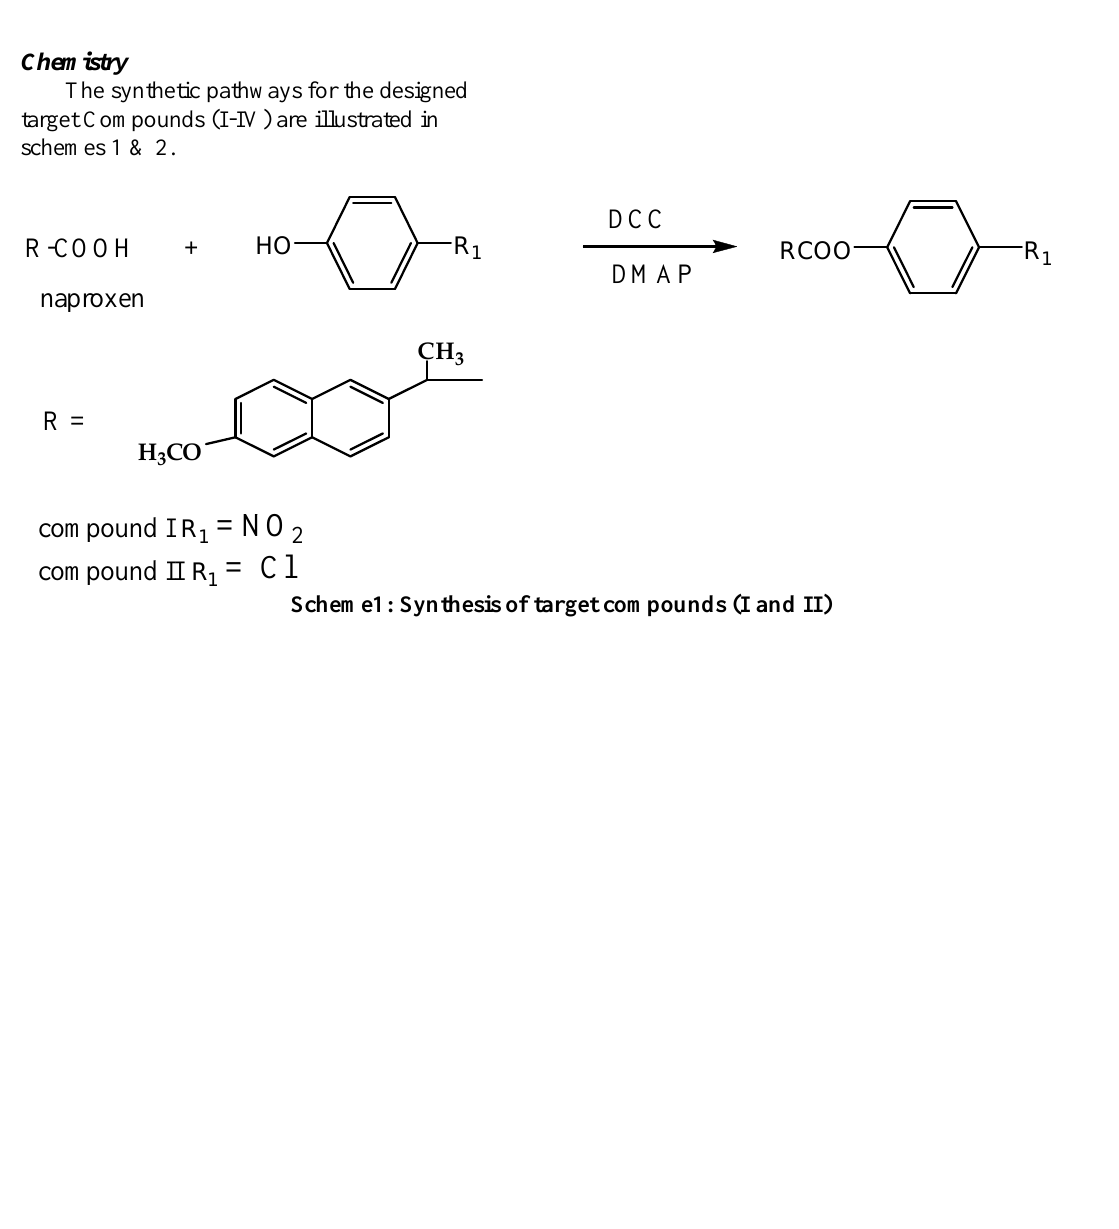
Scheme2. Synthesis of target compounds (III and